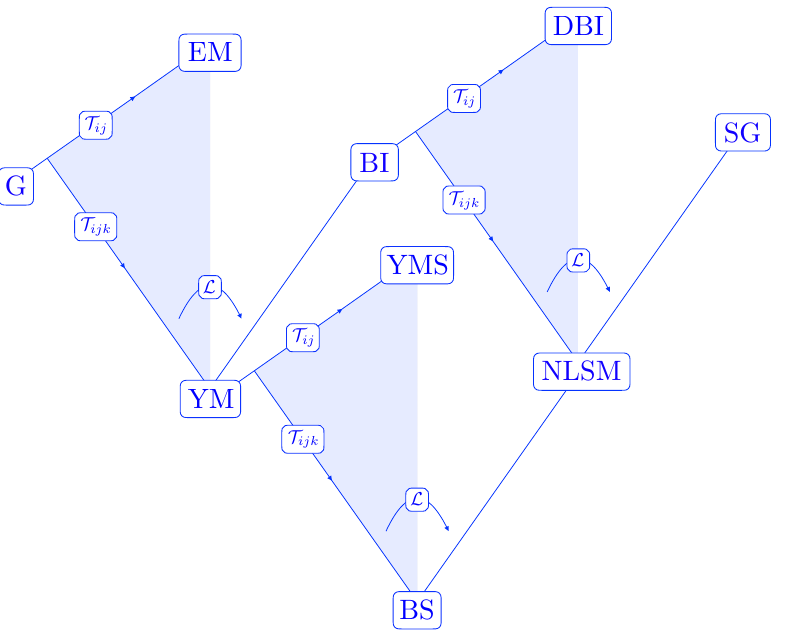
Figure 1 . Diagram depicting the uni(cid:12)ed web of theories. The corners represent extended gravity (G), Einstein-Maxwell (EM) theory, Yang-Mills (YM) theory, Born-Infeld (BI) theory, Dirac-Born- Infeld (DBI) scalar theory, nonlinear sigma model (NLSM), special Galileon (SG), Yang-Mills scalar (YMS) theory, and biadjoint (BS) theory. The arrows correspond to the transmutation operators, , , and . The shaded regions and edges correspond to hybrid T ij T ijk L